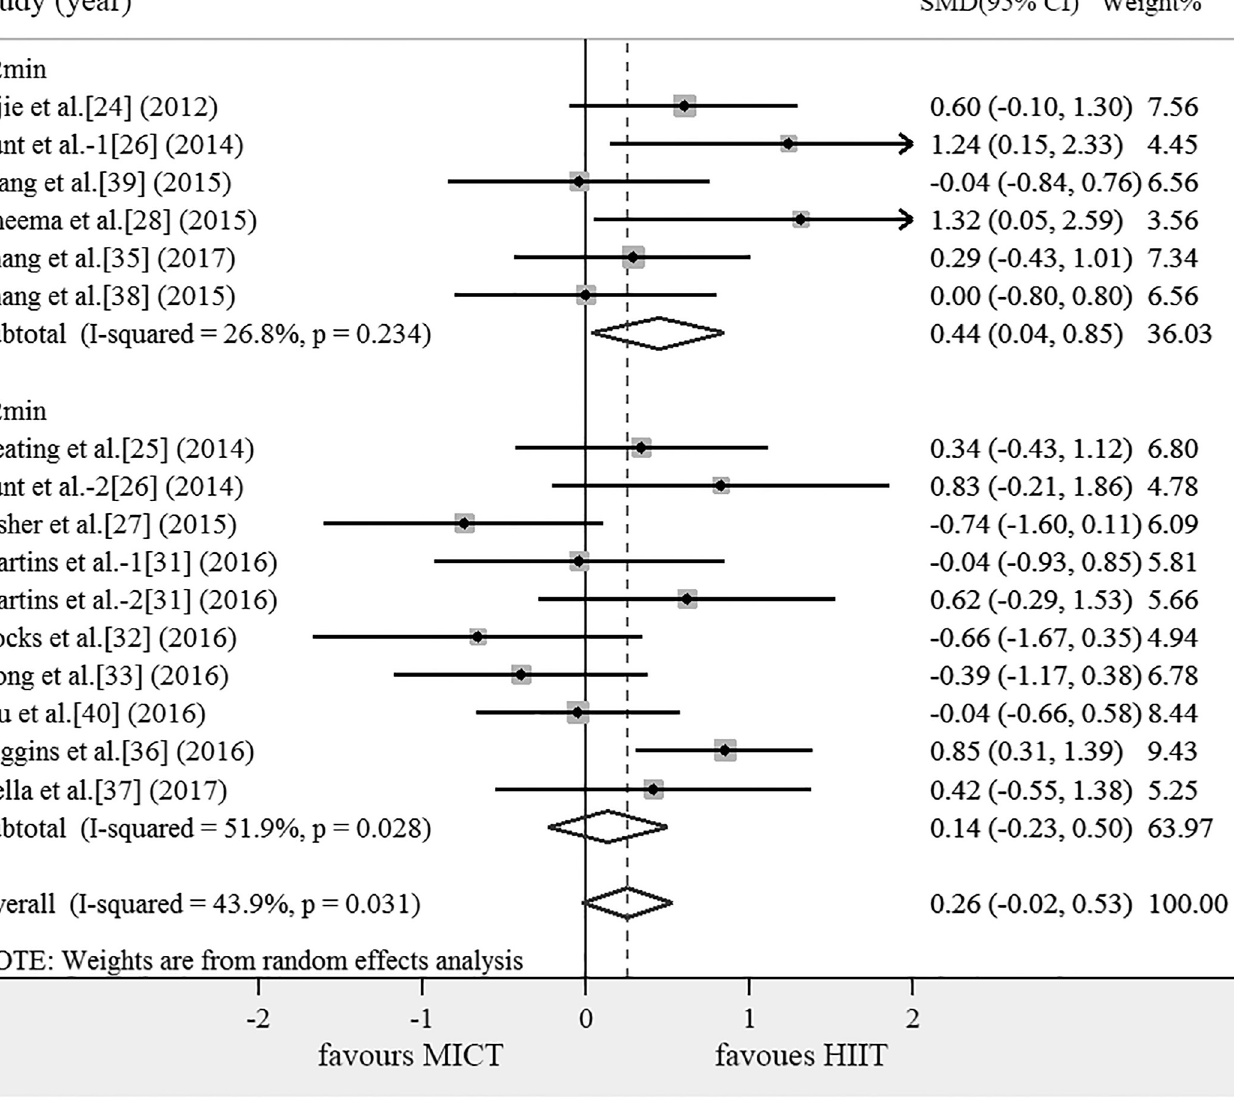
Fig 2. Meta-analysis for the comparison of HIIT vs. MICT for VO 2max with subgroup analyses for studies employing DHTI < 2 min, DHTI � 2 min than MICT. The positive value of X axis indicated that HIIT was more effective than MICT in improving VO 2max . Lunt et al.-1 and Lunt et al.-2 were two different HIIT methods were used in one article. Martins et al.-1 and Martins et al.-2 were two different HIIT methods were used in one article. DHTI < 2 min: HIIT training interval < 2 min, DHTI � 2 min: HIIT training interval � 2